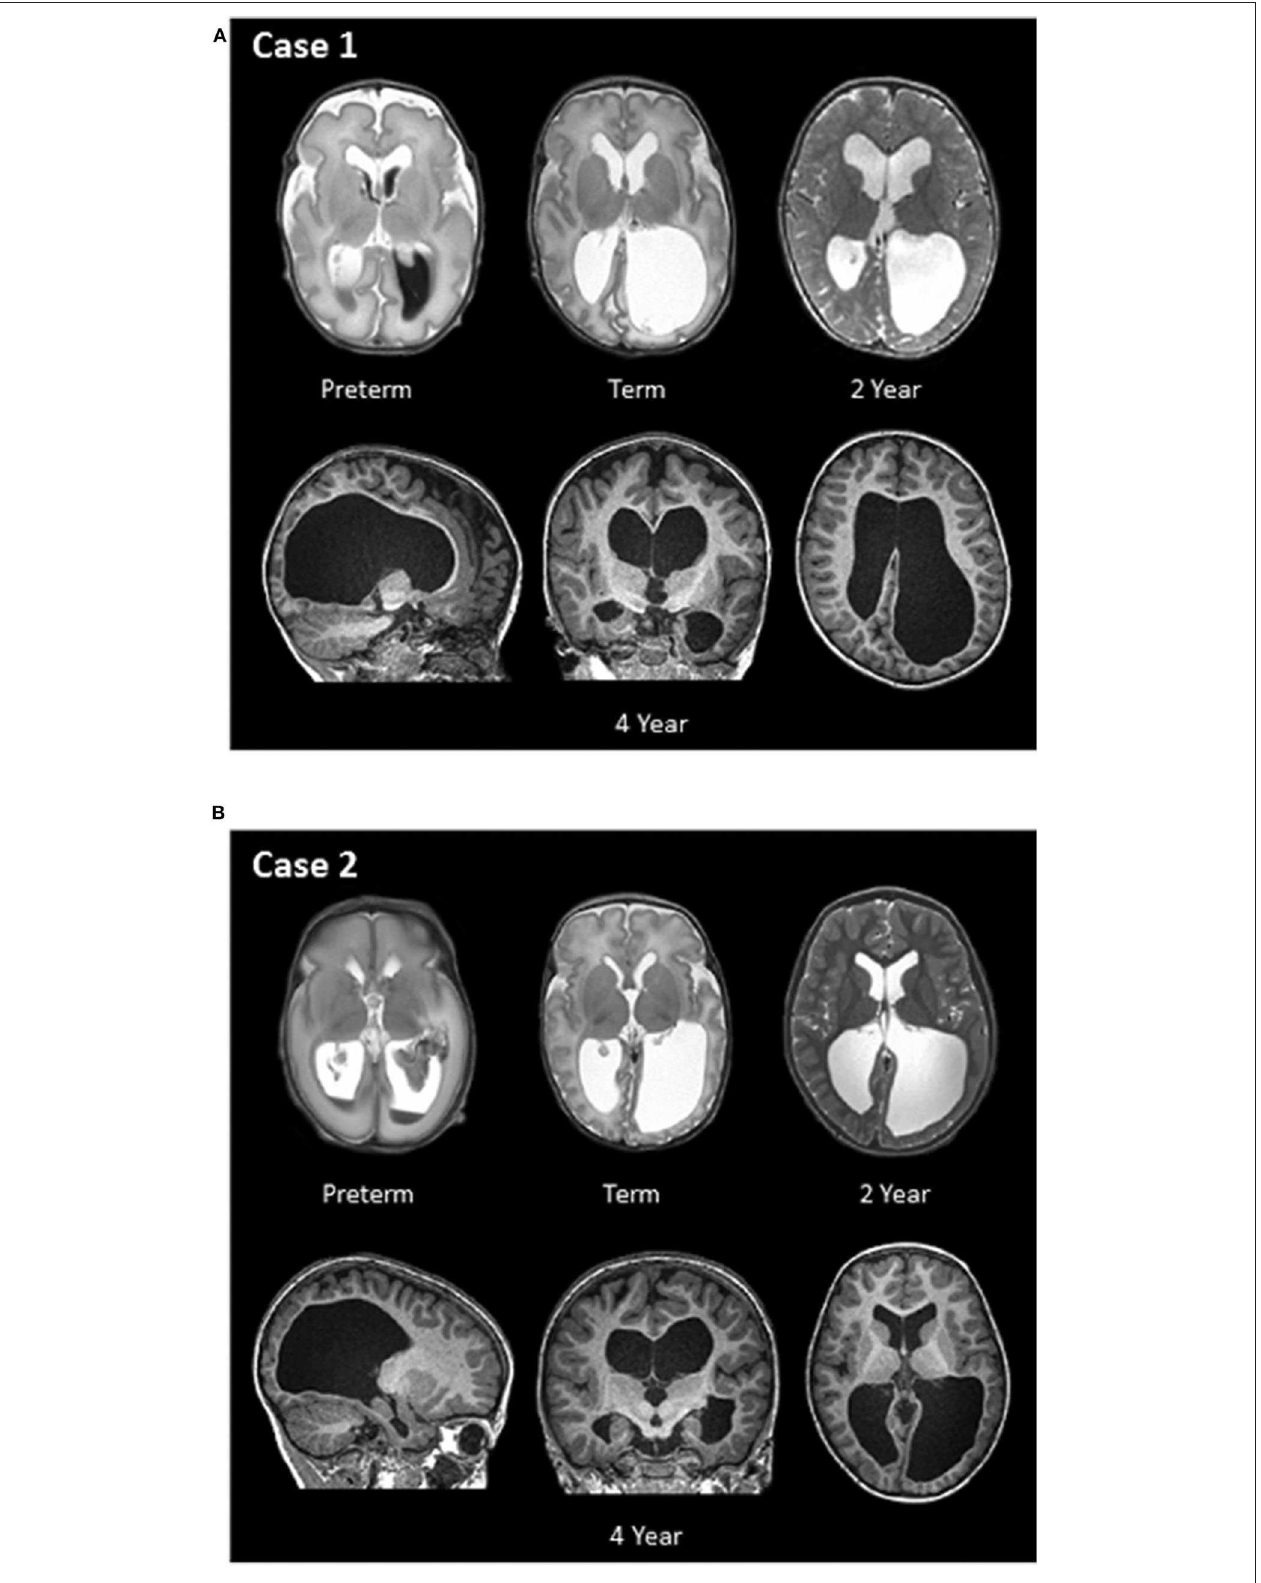
FIGURE 2 | (A,B) Longitudinal structural MR images of Case 1 and Case 2. T2- and T1-weighted MRI images were obtained at four different ages: within two weeks of birth (preterm; top left), term-equivalent age (term; top middle), 2 years of age (top right), and 4 years of age (bottom row).